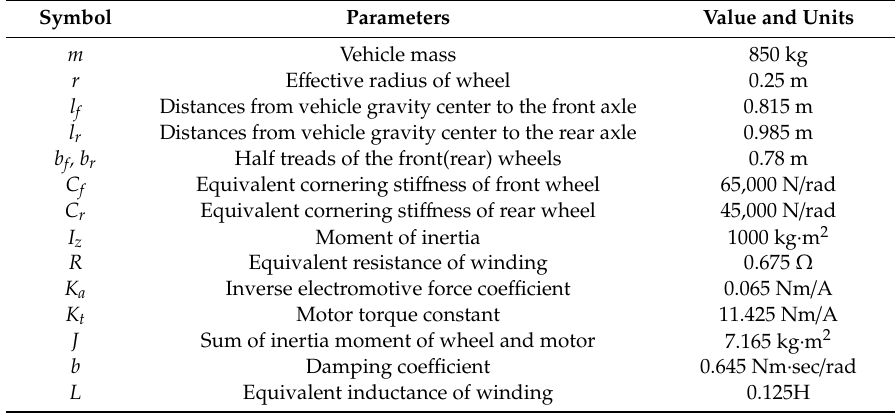
Figure 2. Vehicle modeling in CarSim. Table 1. Vehicle parameters in CarSim simulation